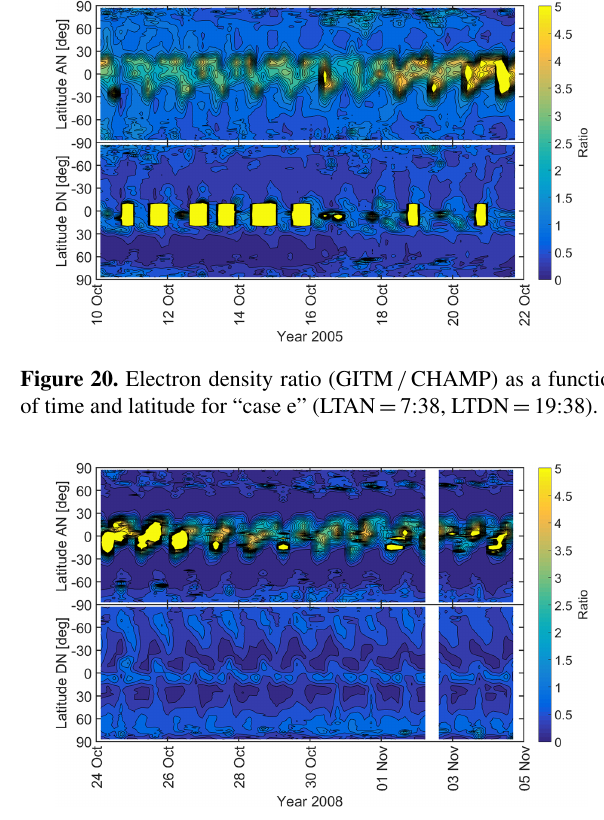
Figure 19. Electron density ratio (GITM / CHAMP) as a function of time and latitude for “case d” (LTAN = 10:01; LTDN = 22:01).